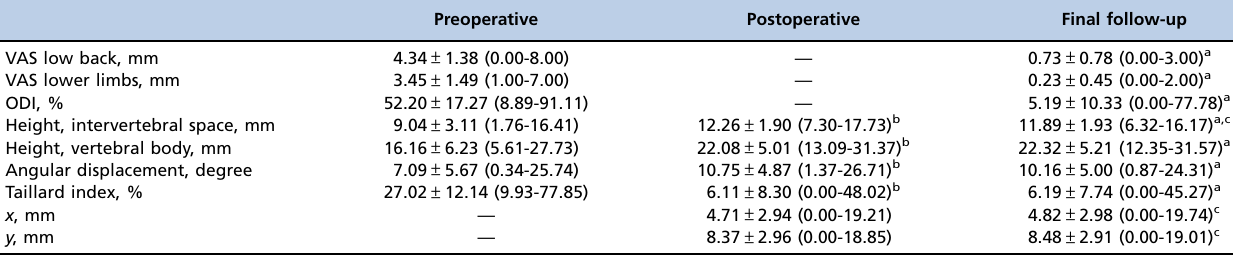
Table 4 - Clinical and radiographic data analysis at three time points for the 128 patients with PMMA-augmented CICPSs inserted in the osteoporotic spine; data are reported as the mean ± SD